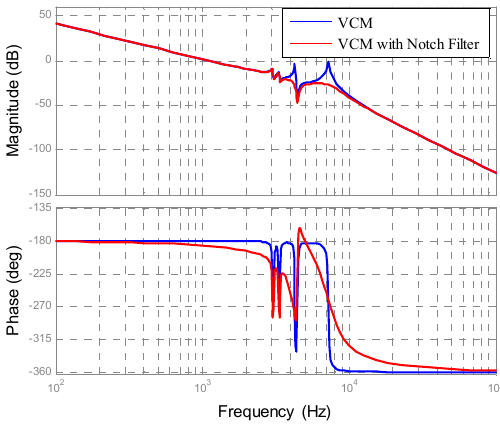
Figure 10. The frequency response of the VCM model, and the VCM model with a notch filter .